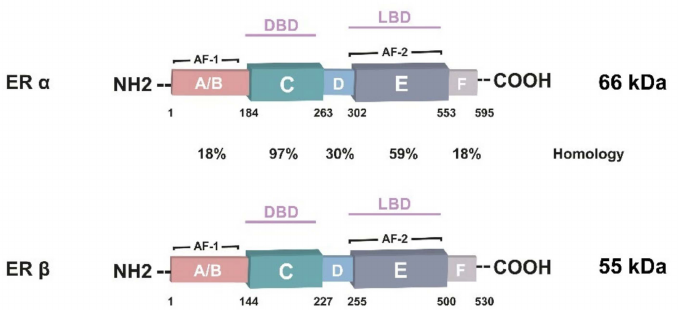
Figure 1. Schematic structure and sequence organization of ER α and ER β . They differ in terms of amino acid numbers. ER α consists of 595 amino acids, while ER β contains 530 amino acids. ER α and ER β share identical characteristics. They are formed by different domains. Amino-terminal A/B domains share 18% amino-acid homology between the ERs. C region (97%) consists of DNA-binding domain. D domain (30%) contains a nuclear localization signal. Multifunctional carboxyl-terminal (E) domain, which shows 59% amino-acid identity between the ERs. The carboxyl-terminal F domain shares an 18% amino-acid identity. (DBD: DNA-binding domain; LBD: ligand-binding domain; AF-1: activation